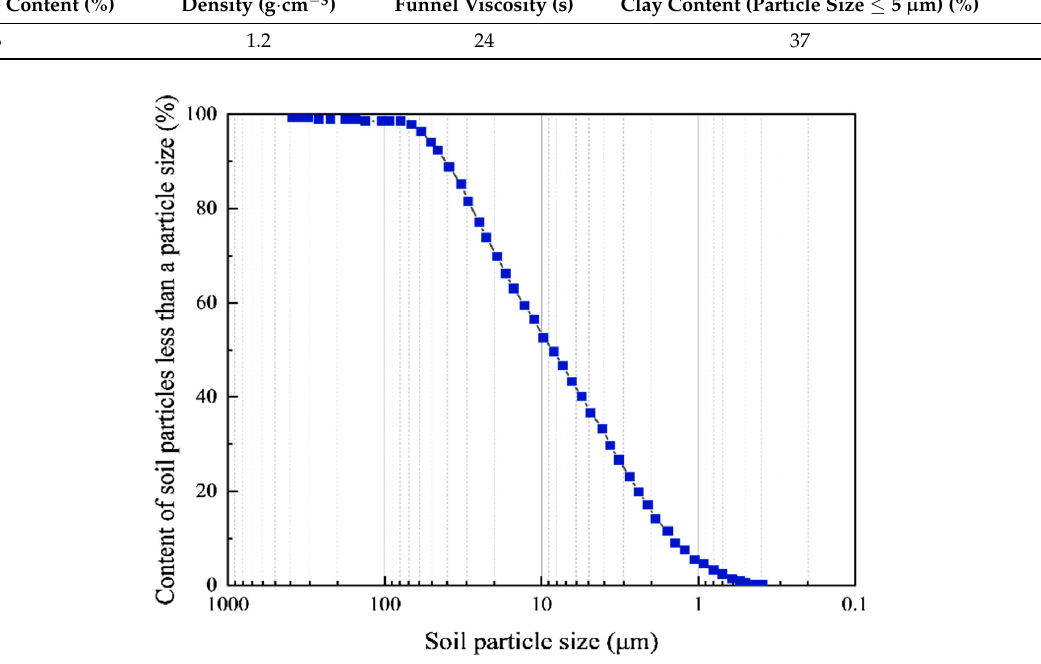
Figure 2. The particle size distribution curve.